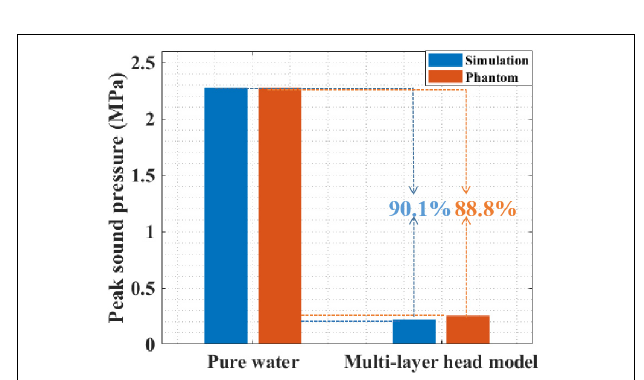
FIGURE 6 | The sound pressure of both pure water and multilayer head model with simulation and phantom